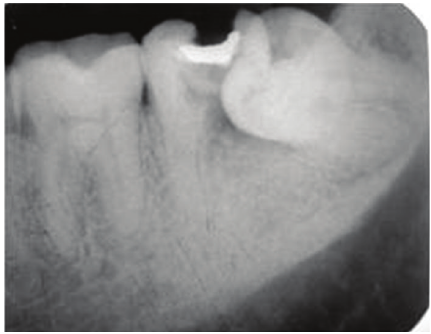
Figure 1: Preoperative radiograph showing 36, 37 and 38.